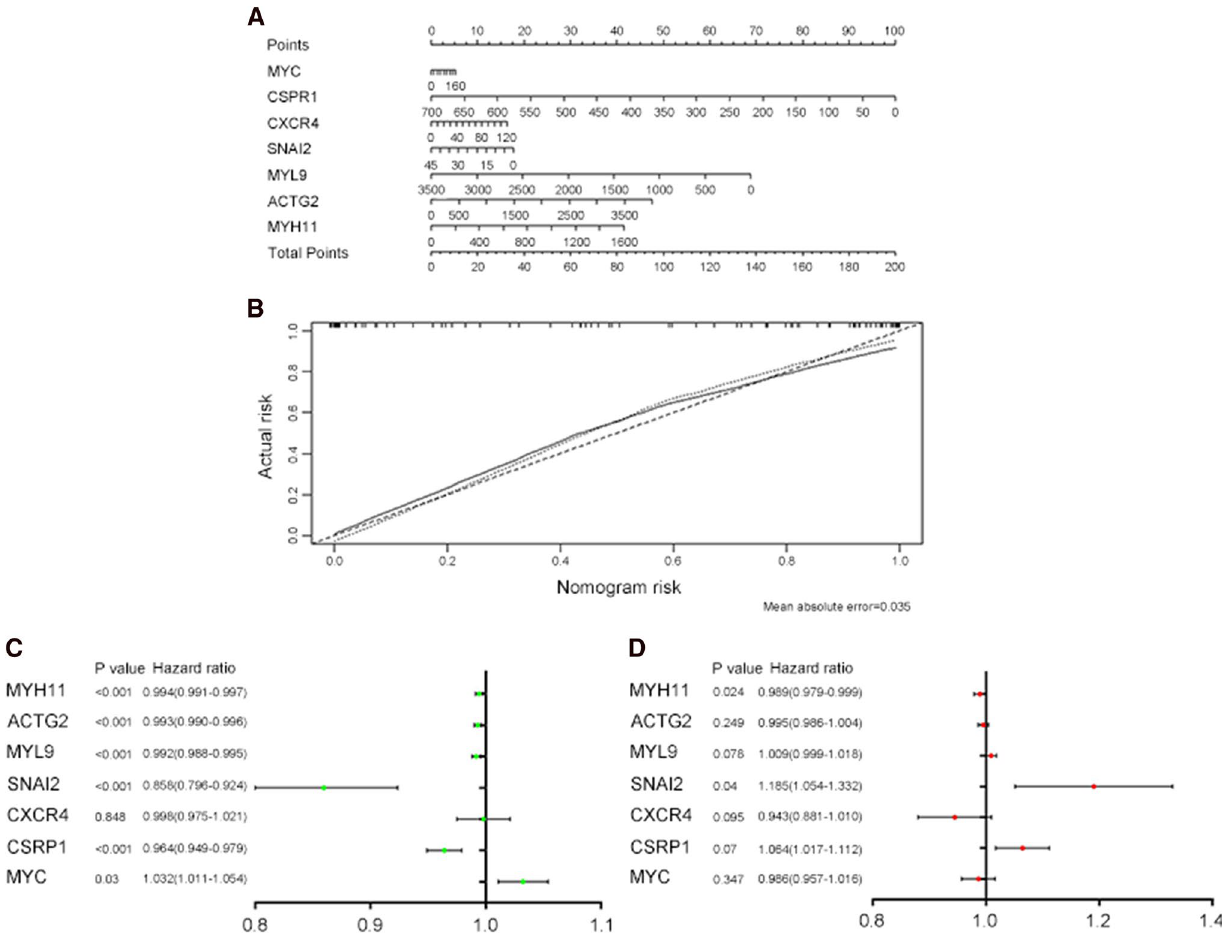
Fig. 6 Risk prediction model of hub genes mutation in leading to PCa on TCGA data. A The nomogram of hub genes expression changes in causing PCa. B Calibration plot of actual risk probability and nomogram risk of nomogram. C The forest map of single factor of regression analysis of hub genes in causing PCa. D The forest map of multiple factors of regression analysis of hub genes in leading to